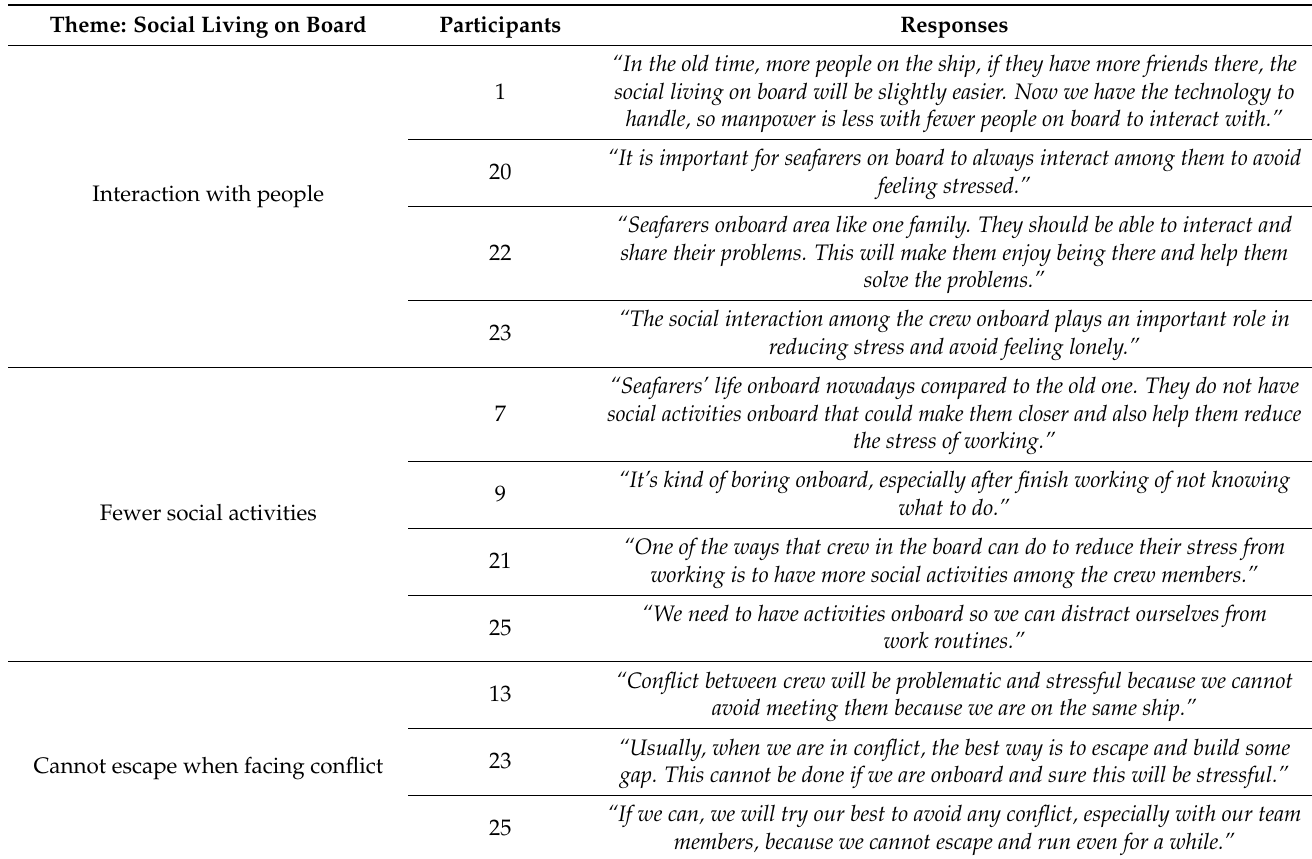
Table 6. Theme of social living